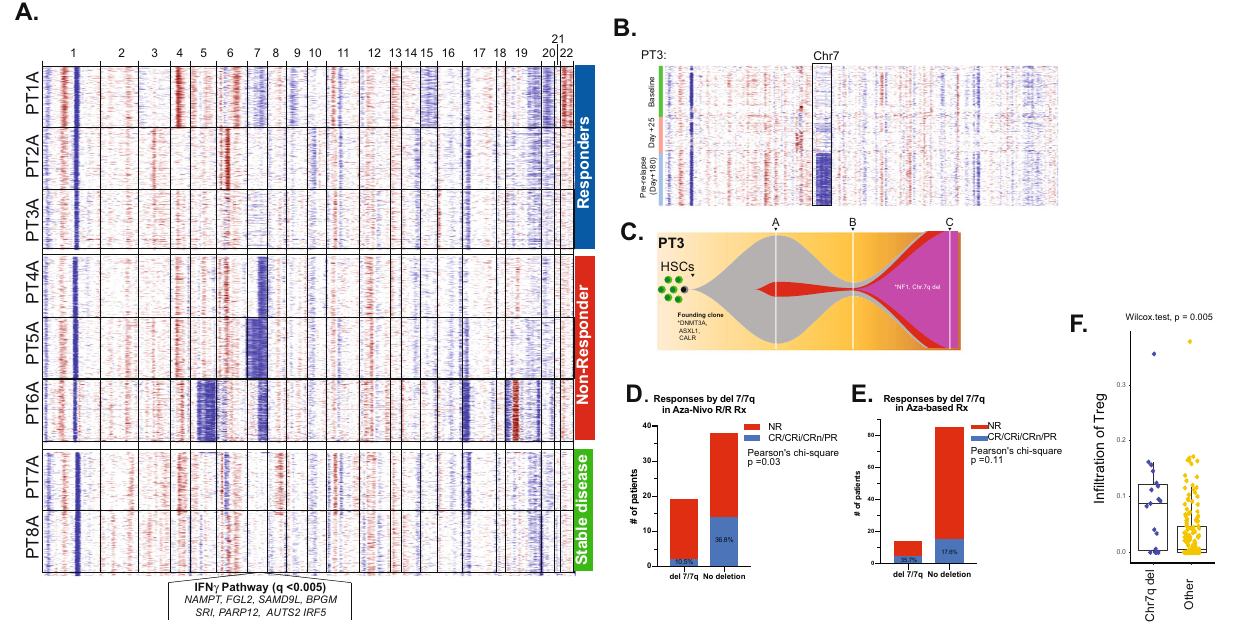
Fig. 6 Correlation of responses with cytogenetics. A Inferred copy number variation of representative 300 cells per patient at pretreatment (timepoint A). B Inferred copy number variation of the 3 timepoints (A, B and C) for PT3 (responder). C Fish plot of mutational evolution of PT3. D A two-sided Pearson ’ s Chi-square for correlation analysis for responders to azacitidine/nivolumab and E azacitidine-based therapy based on chr7/7q deletion. F Mann – Whitney, two-sided test for CIBERSORTx analysis of T reg cell components in AML from TCGA by chr7/7q status ( n = 19 for del7/7q and n = 152 for no deletion in chr7/7q). Center line represents the main and lower and upper hingest correspond to the fi rst and third